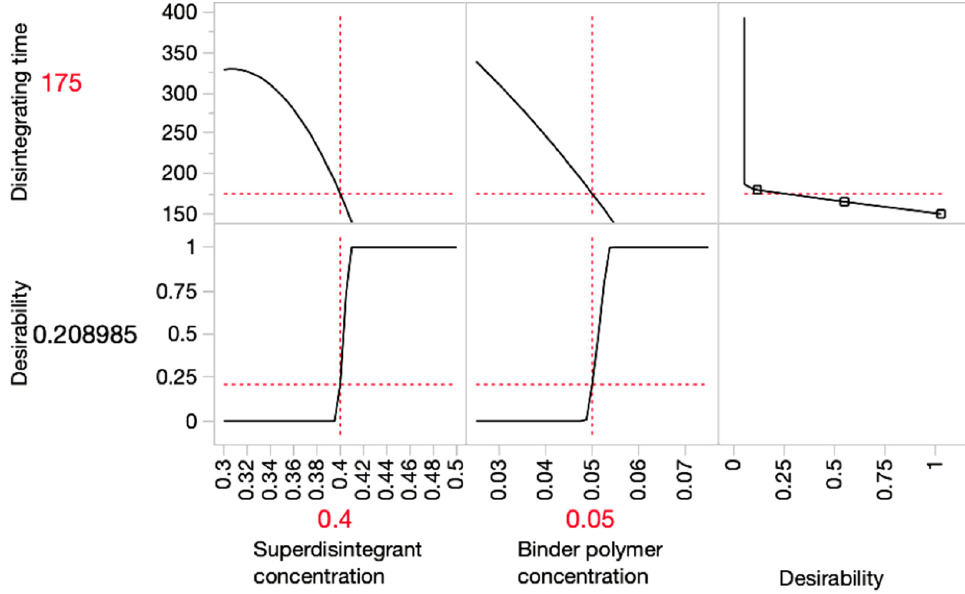
Figure 3. Prediction profiler graph for predicting the optimal formulation for minimising disinte- grating time.